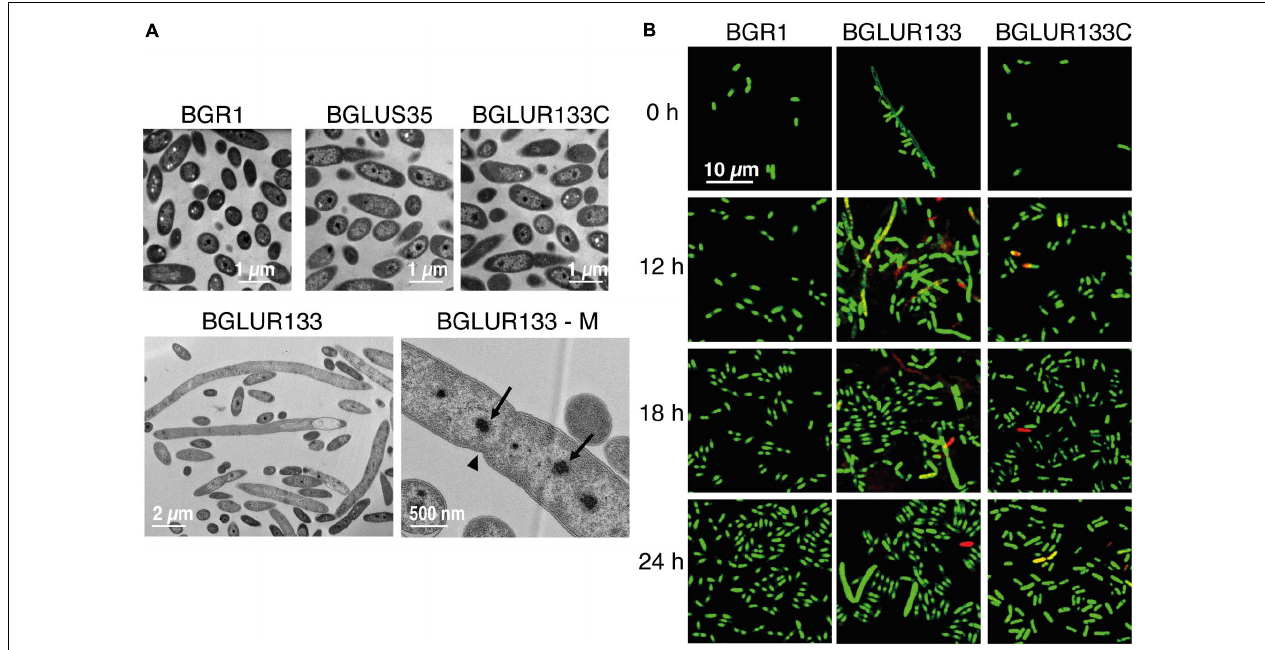
FIGURE 3 | The gluR mutant forms a heterogeneous population of viable filamentous and normal rod-shaped cells. (A) The indicated bacterial strains were grown to the early stationary phase, and the morphological phenotypes of ultrathin sections were observed by transmission electron microscopy (TEM). BGLUR133-M shows that the filamentous cells formed by the gluR mutant contained multiple nuclei (arrows) with indents (arrowhead) along the cell wall, symbolizing failed septum formation. (B) Cell viability of the wild type, BGLUR133, and complemented BGLUR133C strains assessed by combination staining with propidium iodide (PI) and SYTO 9 green. Fluorescence images were obtained by confocal laser scanning microscopy. Dead cells stained with PI are red, and SYTO 9-stained viable cells are green.